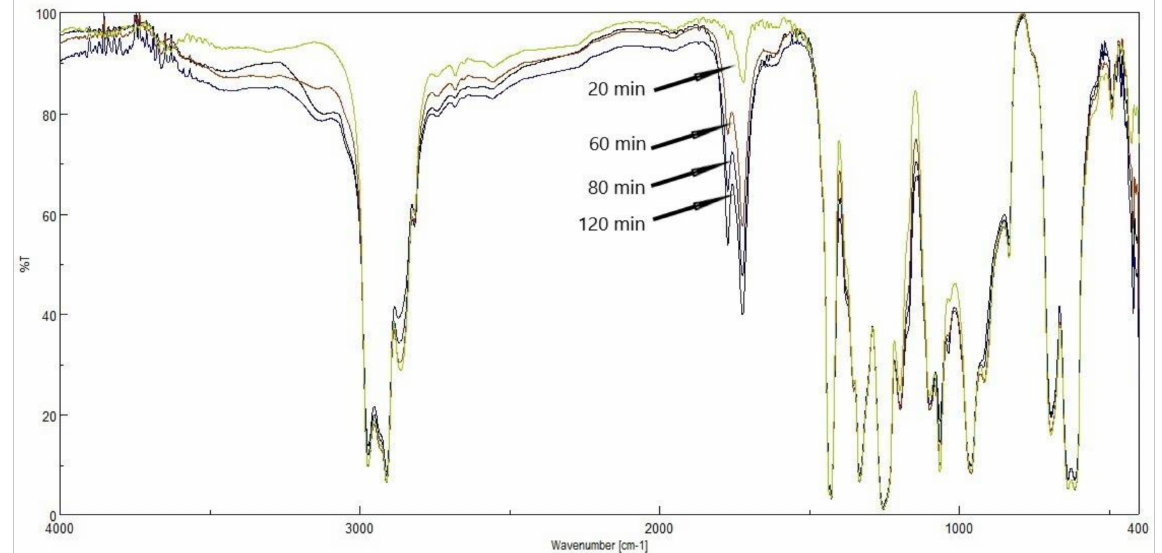
Figure 2. Attenuated total reflection-Fourier transform infrared (ATR-FT-IR) spectra of blank polyvinyl chloride (PVC) film during thermal